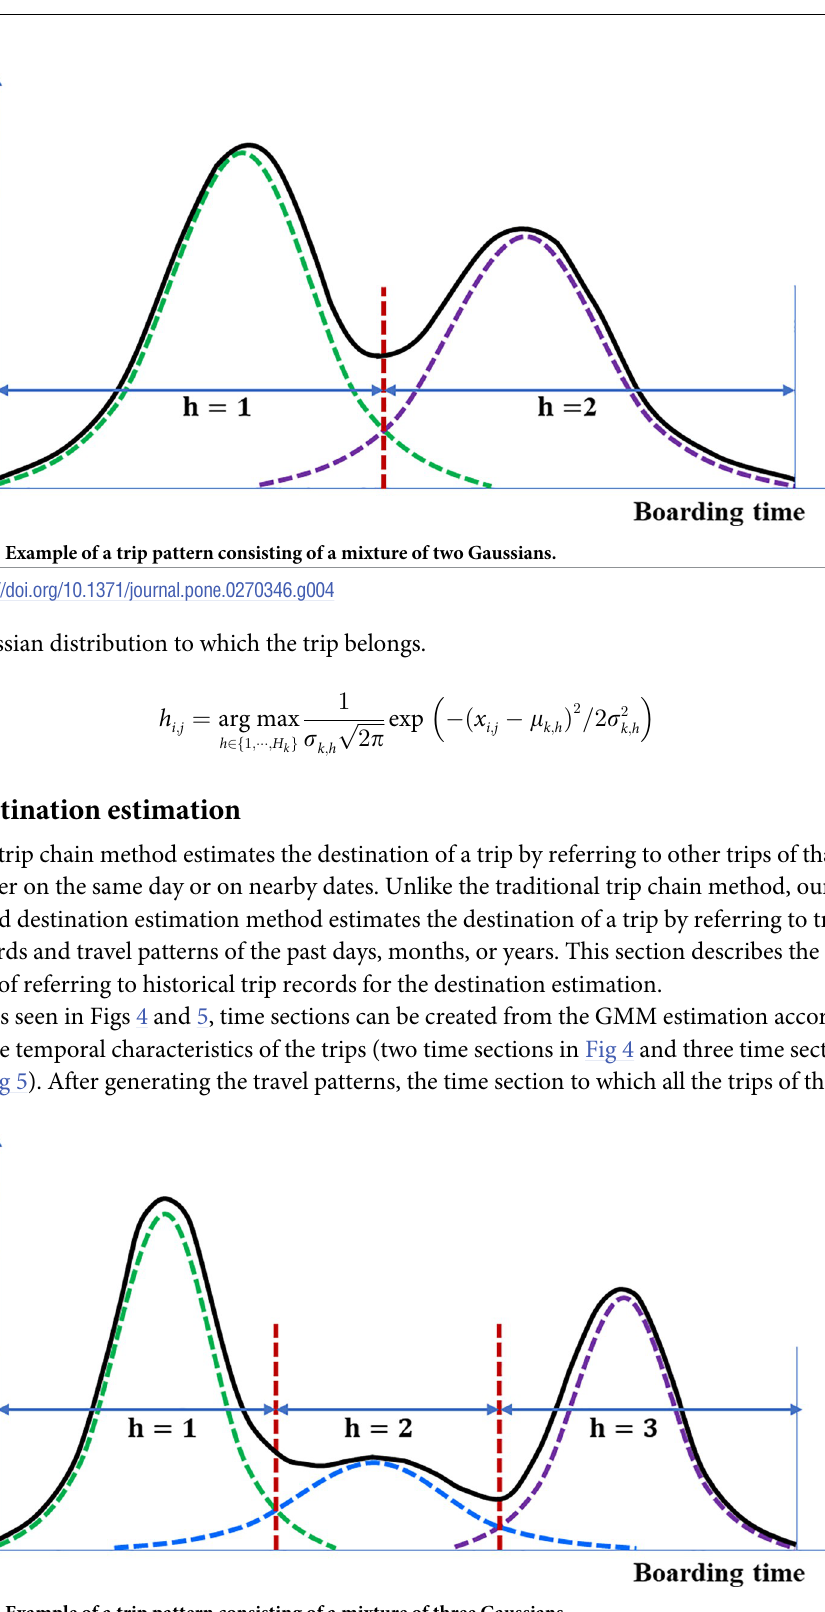
Fig 5. Example of a trip pattern consisting of a mixture of three